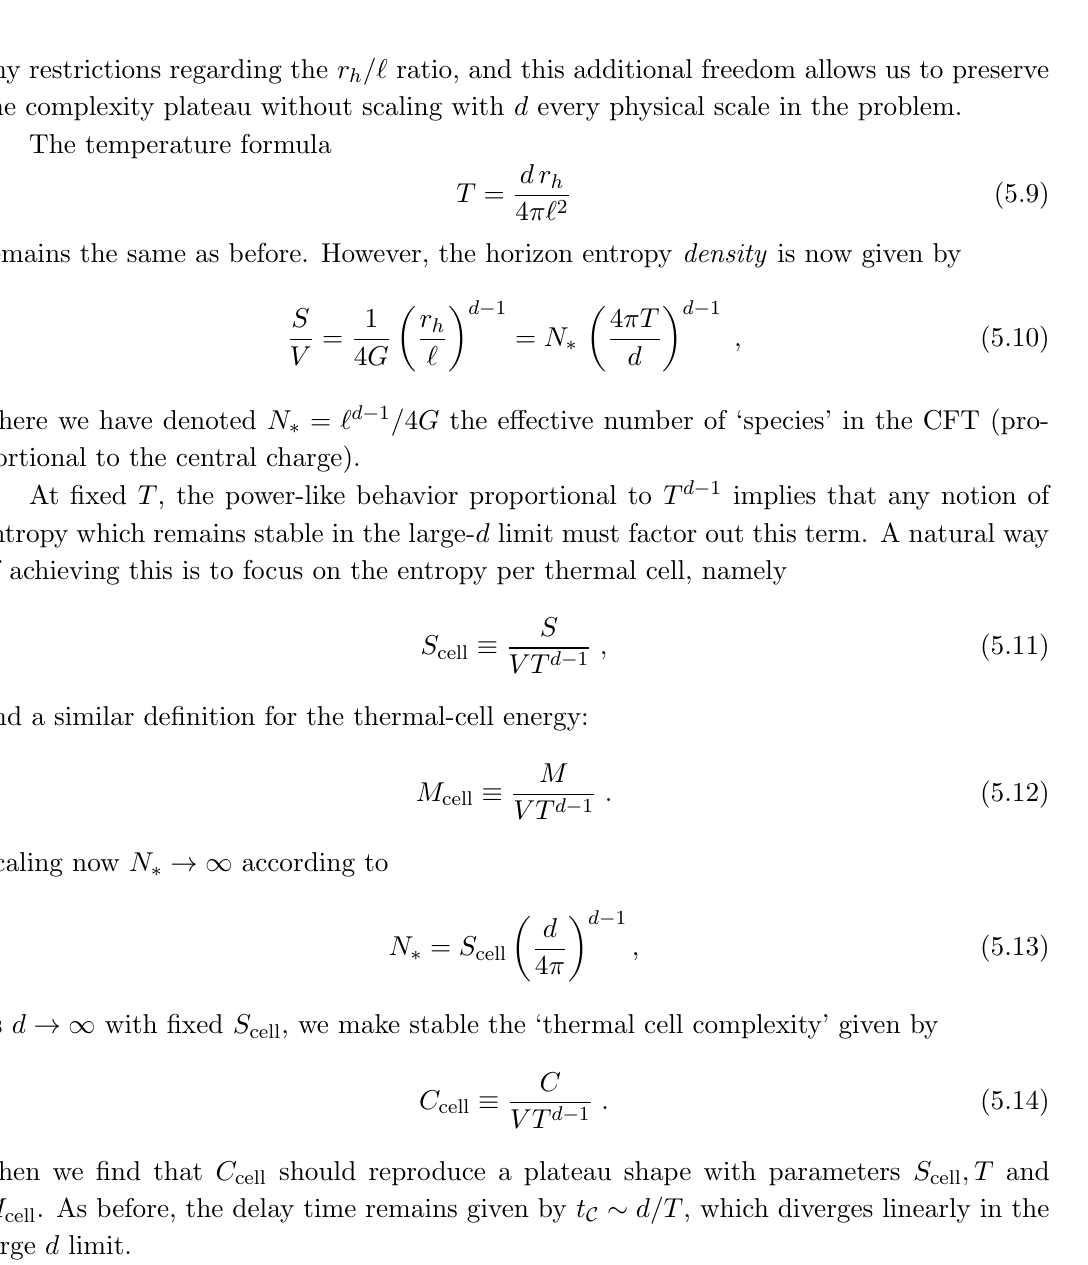
Figure 6 . Plateau shifting of large d AdS black